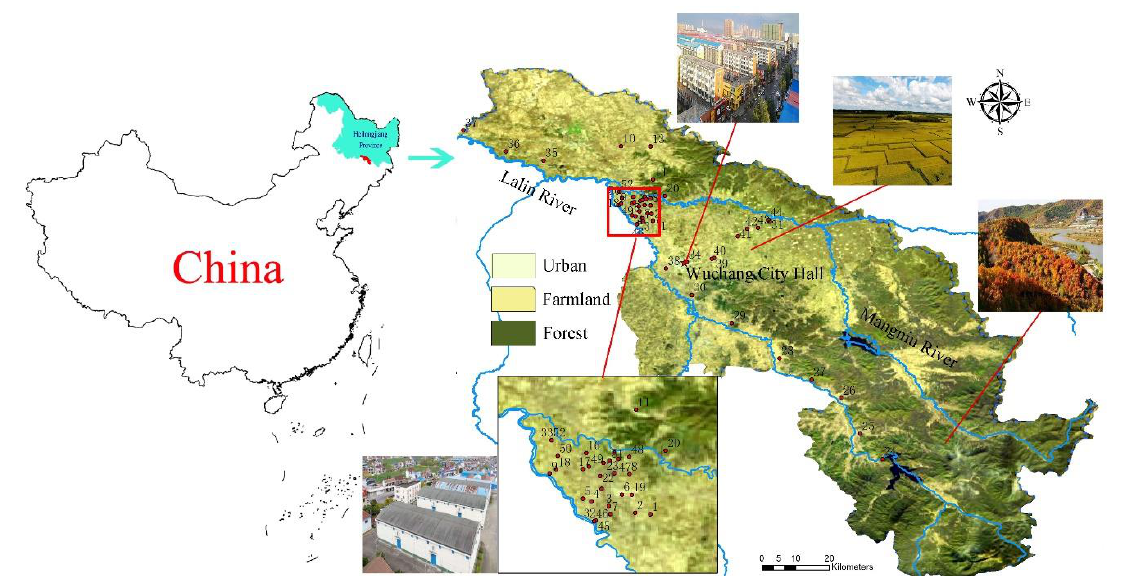
Figure 1. Location of the study area and sampling points.